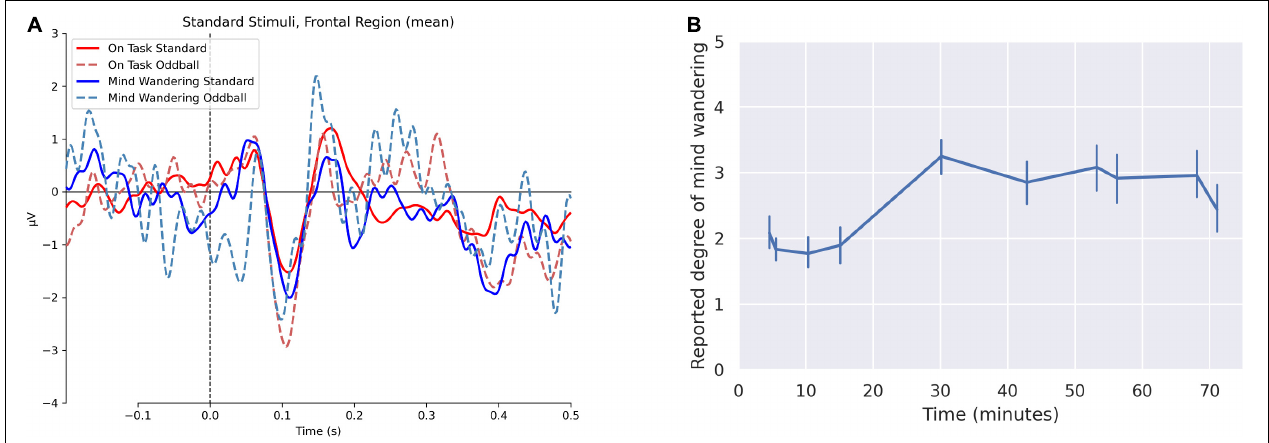
FIGURE 1 | (A) Effect of the reported mind wandering states (i.e. “completely on task”, “completely mind wandering”) on event-related potentials elicited by standard and oddball stimuli. Images depicted are grand average waveforms at channels Fz, F3, F4, FC3, FC4, Cz, C3, and C4 for the two states. (B) Variances of self-reported mind wandering over time, with 95% confidence interval error